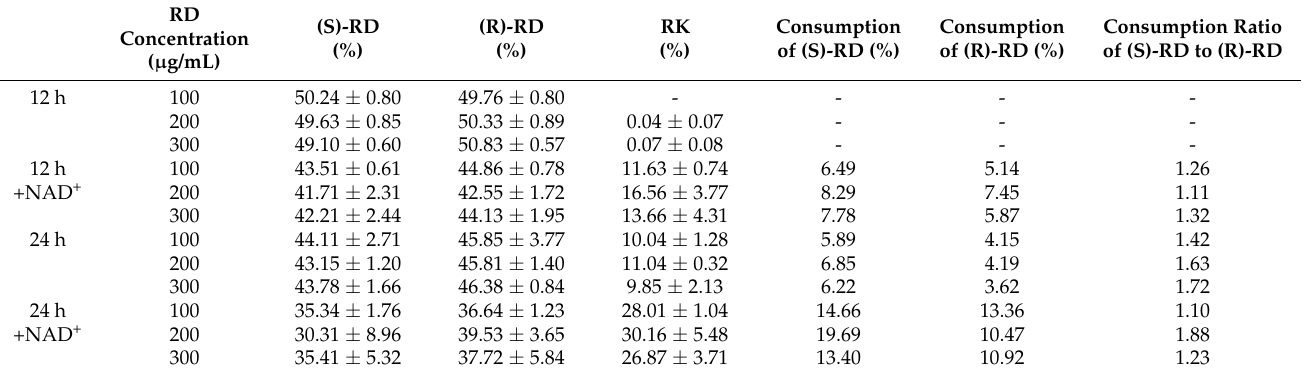
Table 1. Metabolism of RD enantiomers to RK in human skin homogenates exposed to different RD concentrations in the presence of NAD + after 12 and 24